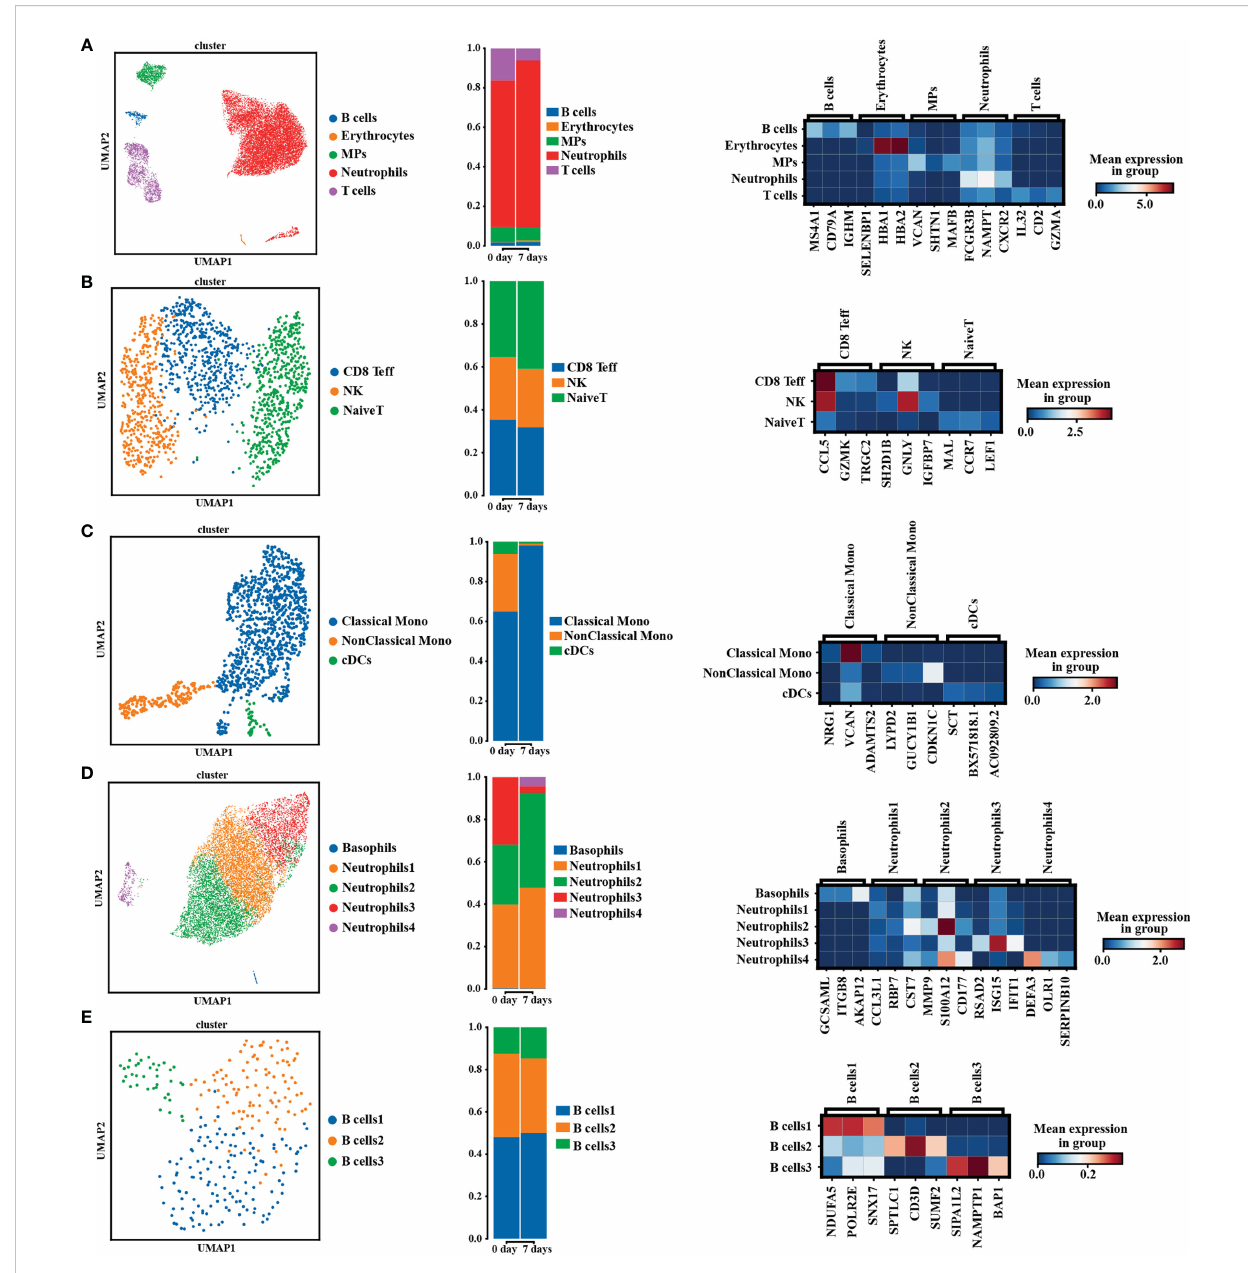
FIGURE 4 Single-cell sequencing analysis. The analysis of PBMCs ’ composition in pALG group on POD0 and POD7. [ (A – E) , left] UMAP cluster cell analysis of PBMCs, T cells, MPs, neutrophils and B cells. Each dot corresponds to a single cell. [ (A – E) , middle] Percentage of different cell types. [ (A – E) , right] Heatmaps shows the 3 genes with the highest expression levels in each subcluster, with columns representing selected marker genes. UMAP, uniform manifold approximation and projection. MPs, mononuclear phagocytes. CD8 Teff, CD8 effector T cells. Mono, monocytes. cDCs, conventional